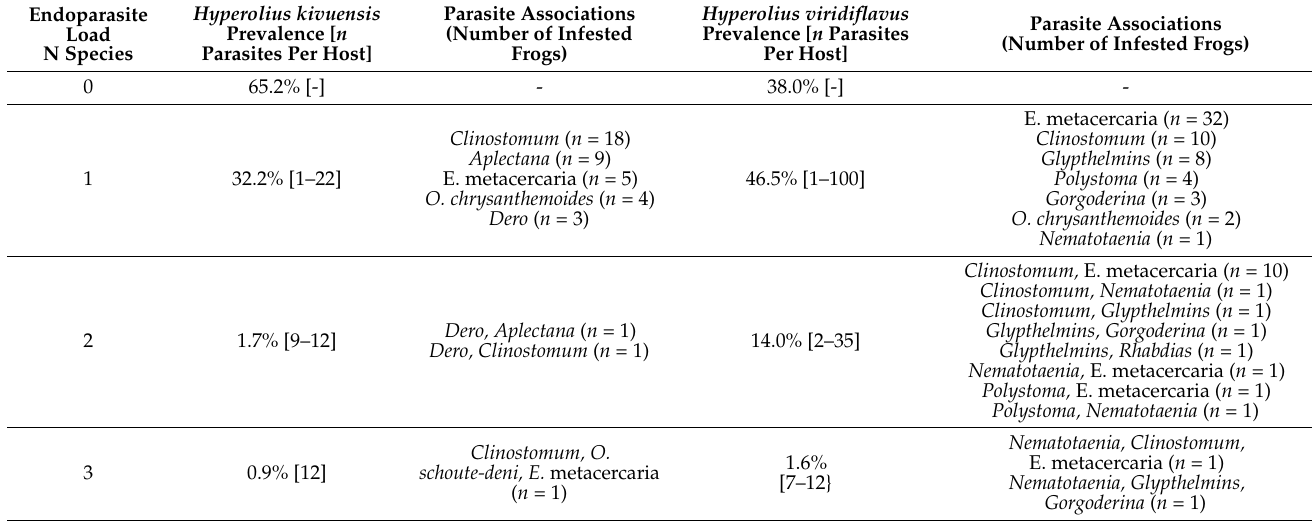
Table 3. Helminth parasite load, parasite association and overall prevalence in host species.